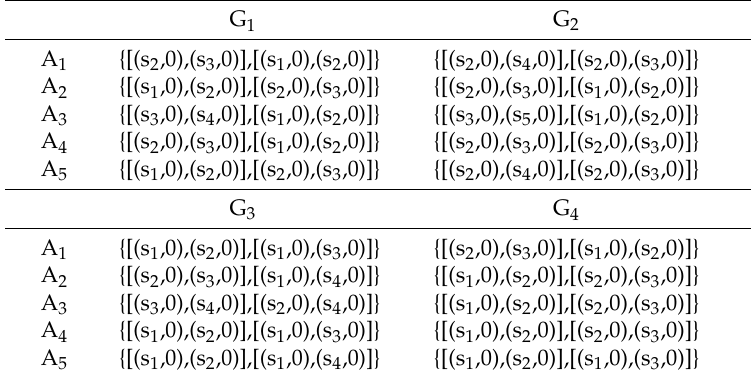
Table 1. The interval-valued 2-tuple linguistic Pythagorean fuzzy number decision matrix.